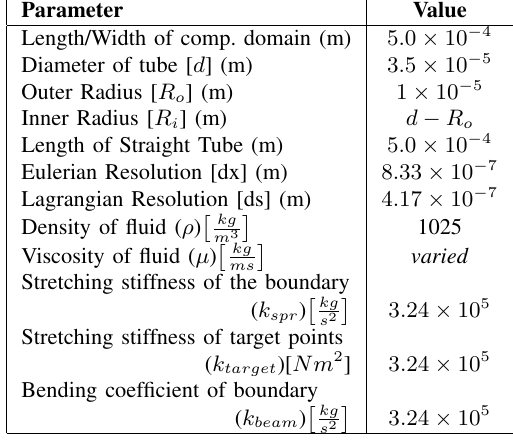
TABLE I: Table of the parameters associated with the fluid and the immersed boundary fiber models.